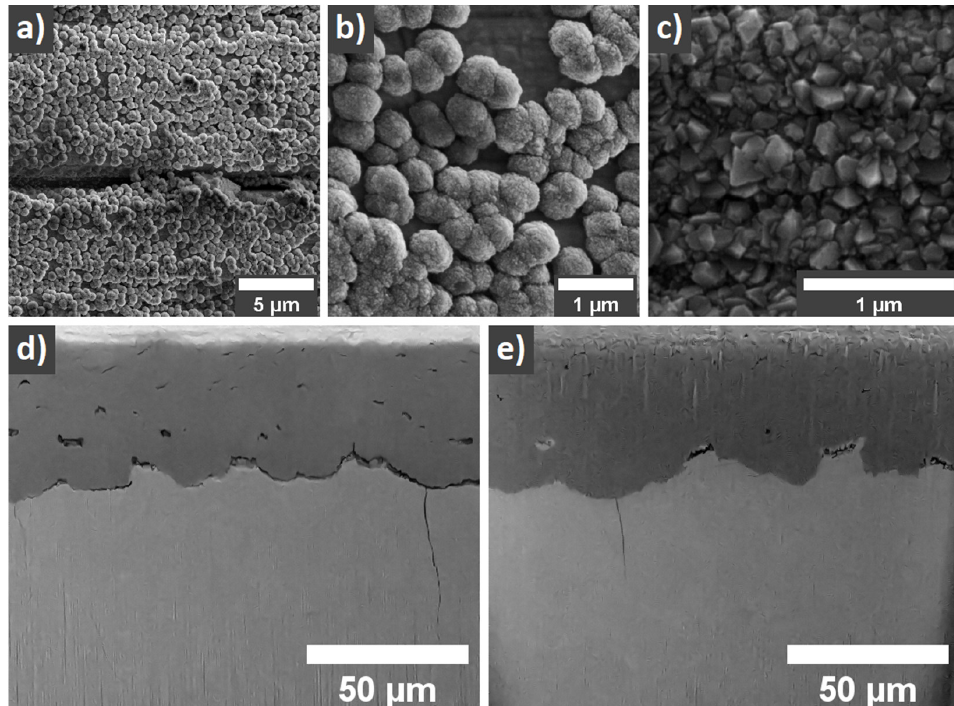
Figure 1. Scanning electron microscopy of as-prepared and hot steam-treated-coated ZIRLO fuel rods. ( a , b ) SEM of the carbon layer (<60% of diamond phase) coated ZIRLO samples as prepared. The low surface density coverage is clearly seen. ( c ) SEM of PCD coating (>95% of diamond phase) of ZIRLO samples as presented in our previous studies [1–3]. SEM images of ZIRLO samples after hot steam oxidation (30 min at 900 °C and 20 min at a 1000 °C in a hot steam furnace) showing structures unveiled using an Xe FIB ( d , e ). The sample without any protection ( d ) has an oxidation layer filled with massive cracks. The sample protected by the diamond coating ( e ) has a smaller number of cracks, both in the oxidized layer and at its boundary with ZIRLO. The oxidized layer can be distinguished as a darker